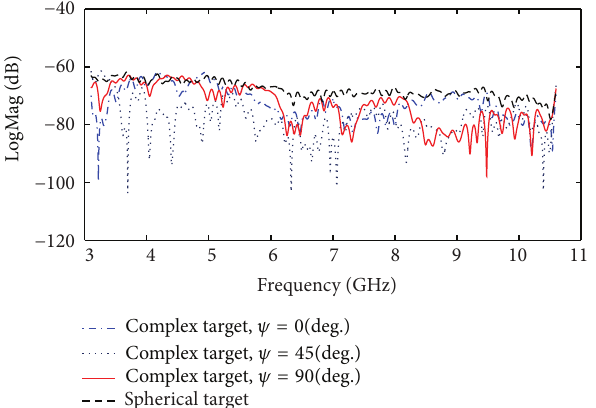
Figure 18: Measured frequency-domain data of the fabricated targets.